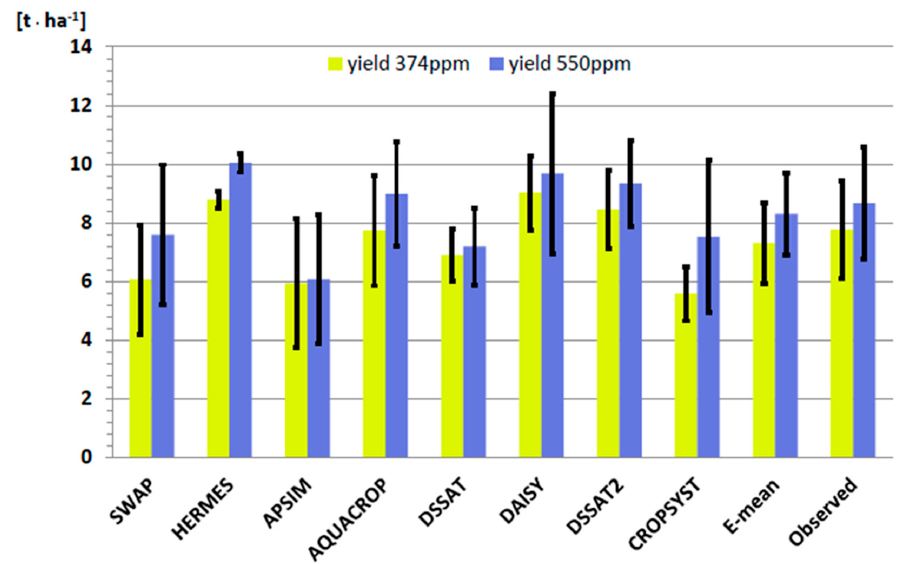
Figure 5. Simulated winter wheat grain yields for ambient (374 ppm) and elevated (550 ppm) atmospheric CO 2 concentration of the Braunschweig FACE experiment from different models. Error bars of the model results and observations show inter ‐ annual variability, error bars of the ensemble mean the inter ‐ model variability.